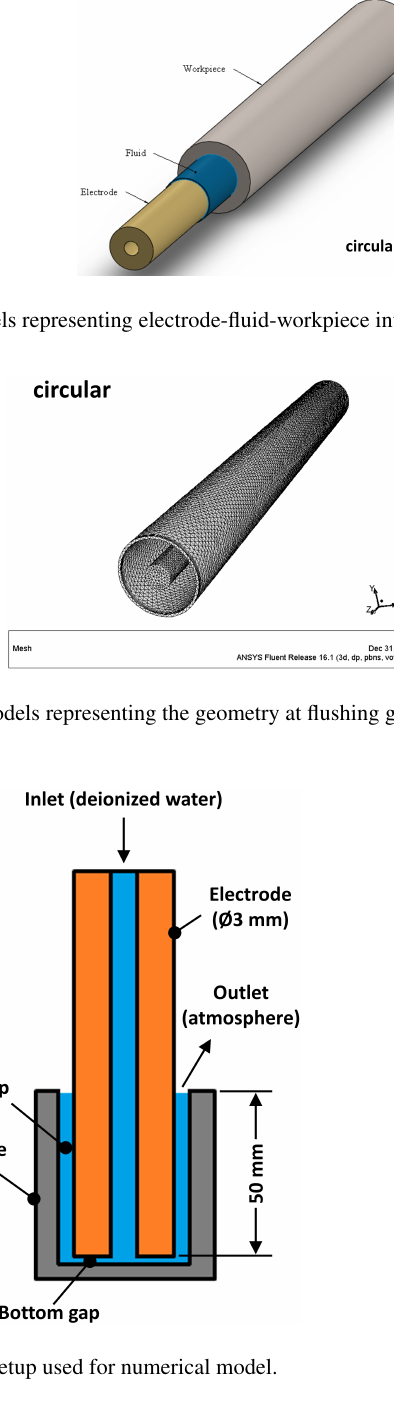
touch with workpiece. The difference between two coordi- nates of electrode was the dimension of bottom gap, which was determined as 480 µm.